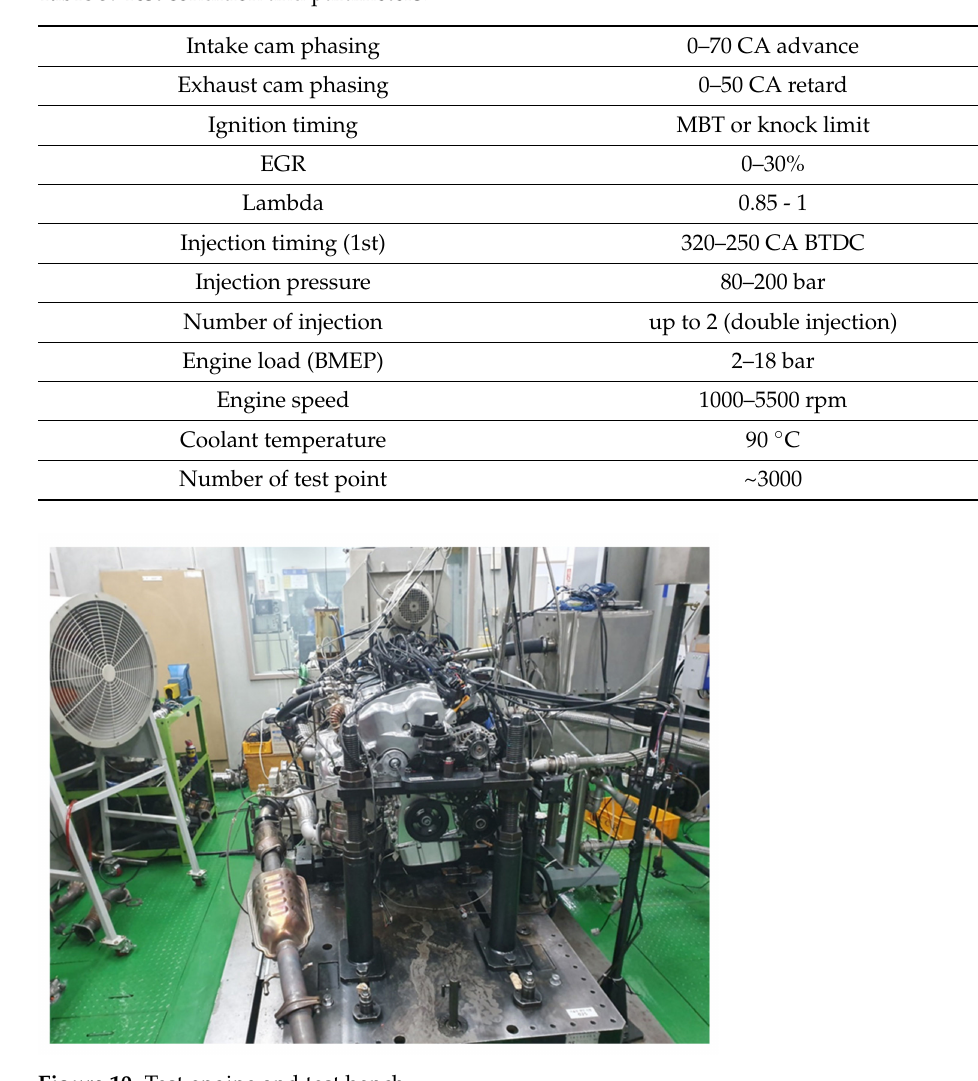
Figure 10. Test engine and test